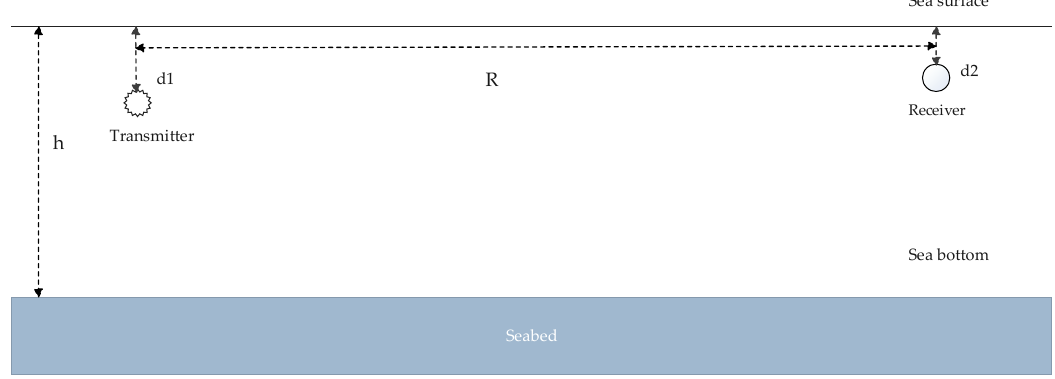
Figure 1. Pekeris model of shallow water acoustic channel .